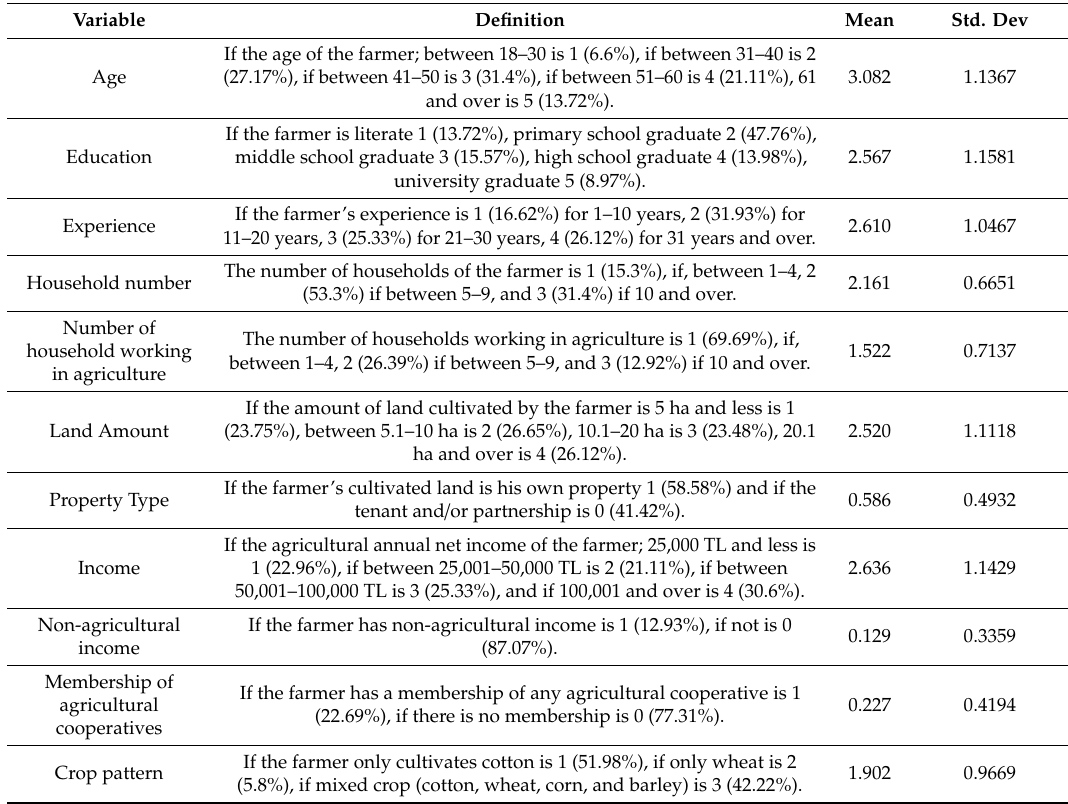
Table 1. Descriptive statistics of the participants.